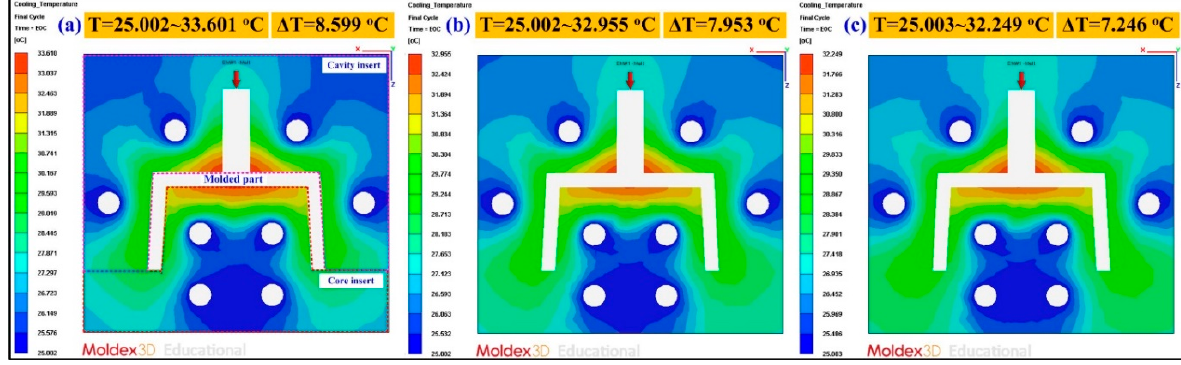
Figure 13. Numerical simulation results of the mold temperature difference for ( a ) conventional SRM, ( b ) SRM with 60 wt.% Al powder, ( c ) SRM made with recipe 4.